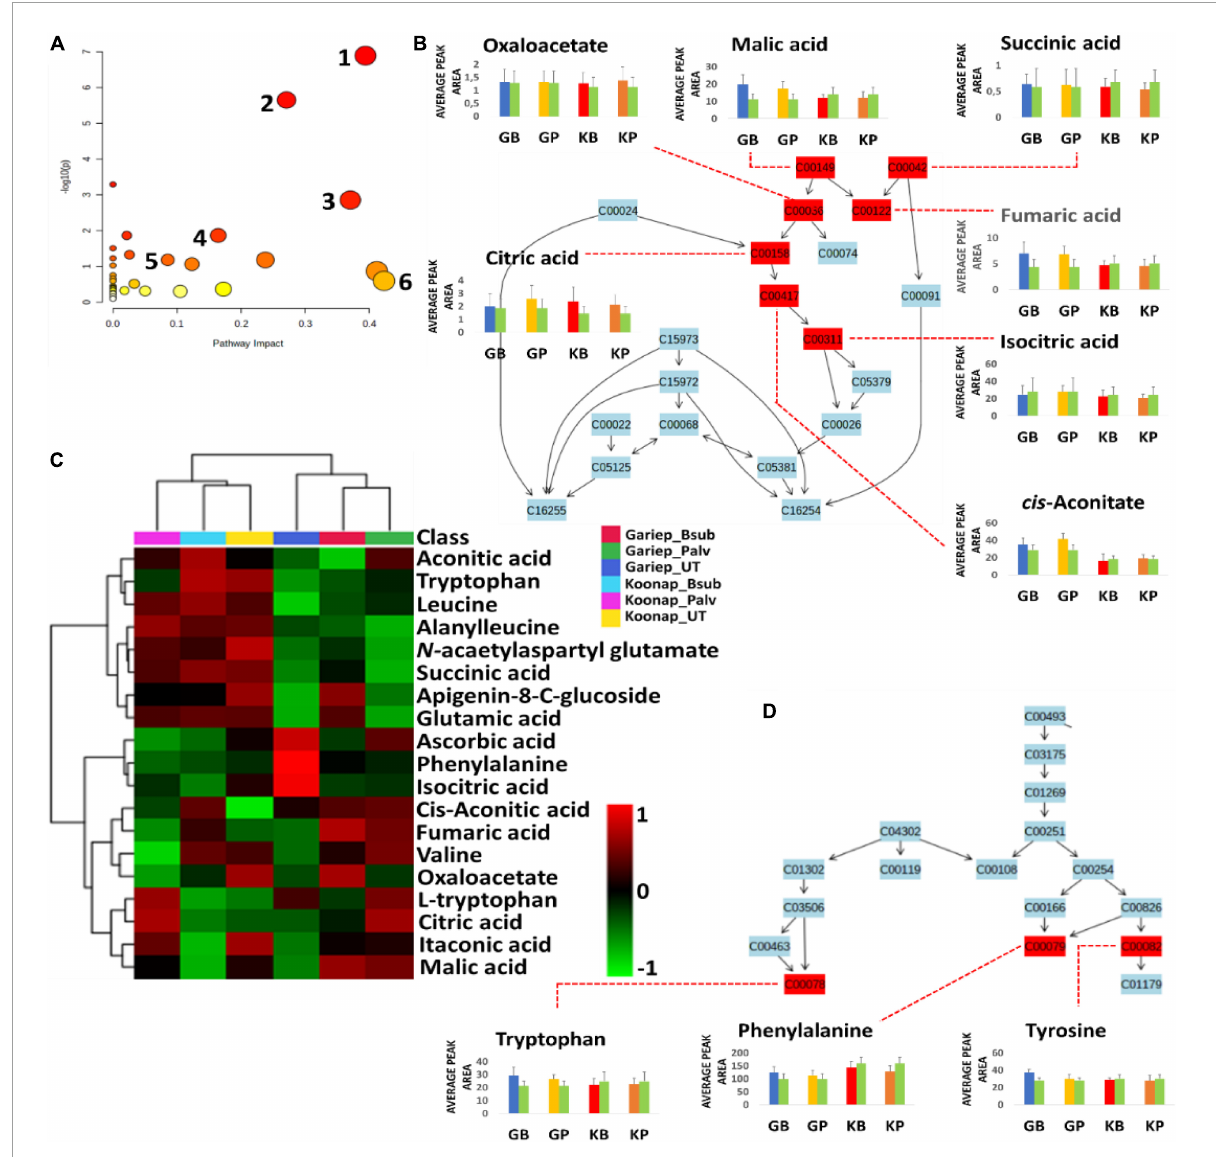
FIGURE8 A summary of metabolic pathways analysis generated in MetPA showing significant and impactful pathways and relative quantification of altered organic acids and amino acids involved in the TCA cycle and aromatic amino acids biosynthesis. (A) A “metabolome view” displaying mapped metabolic pathways arranged by p- value for the most significant pathways on the y -axis and the most impactful arranged by pathway impact on the x-axis. Pathway impact values refer to the cumulative percentage from the matched metabolite nodes and the maximum importance of each pathway is 1. (1) TCA (citrate) cycle, (2) glyoxylate and dicarboxylate metabolism, (3) alanine, aspartate and glutamate metabolism, (4) phenylalanine, tyrosine, and tryptophan biosynthesis, (5) phenylpropanoid biosynthesis, and (6) phenylalanine metabolism. (B) A topological characterization of the TCA cycle with integrated matched intermediates (metabolites) showing altered relative quantification levels (average peak areas). (C) An interactive heatmap showing the differentially altered concentrations of organic and amino acids. (D) Topological characteristics of the aromatic amino acids biosynthesis pathway, showing the quantification levels of tryptophan, phenylalanine and tyrosine under different conditions. GB (blue) = Gariep_ B. sub , GP (yellow) = Gariep_ P. alvei , KB (red) = Koonap_ B. sub , KP (orange) = Koonap_ P. alvei . Green bars represent untreated samples for the respective